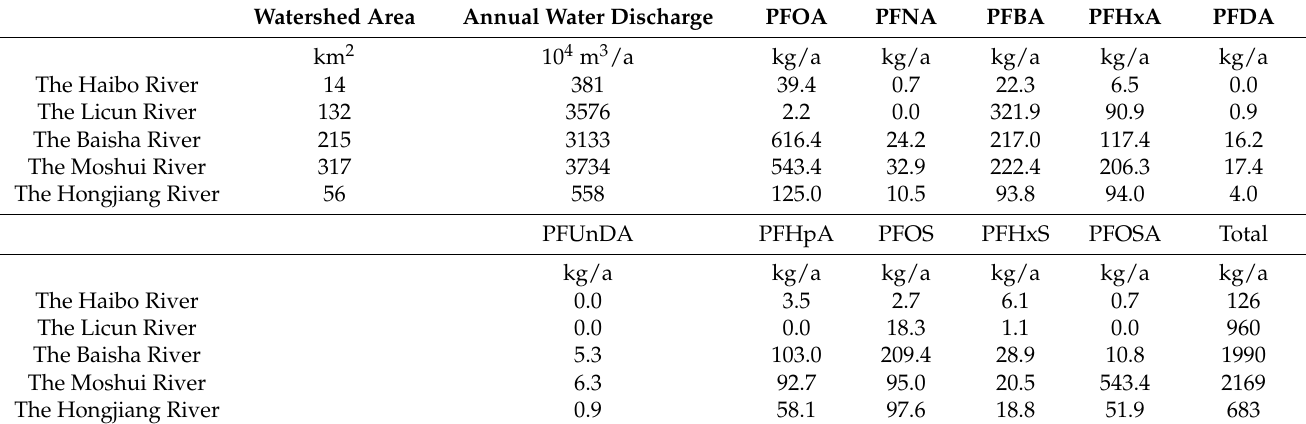
Table 2. The annual input of the PFASs from the riverine outlets to the sea in